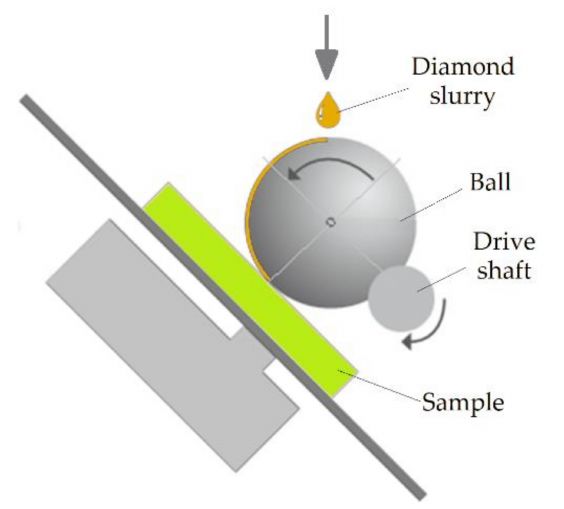
Figure 4. Scheme of water-jet